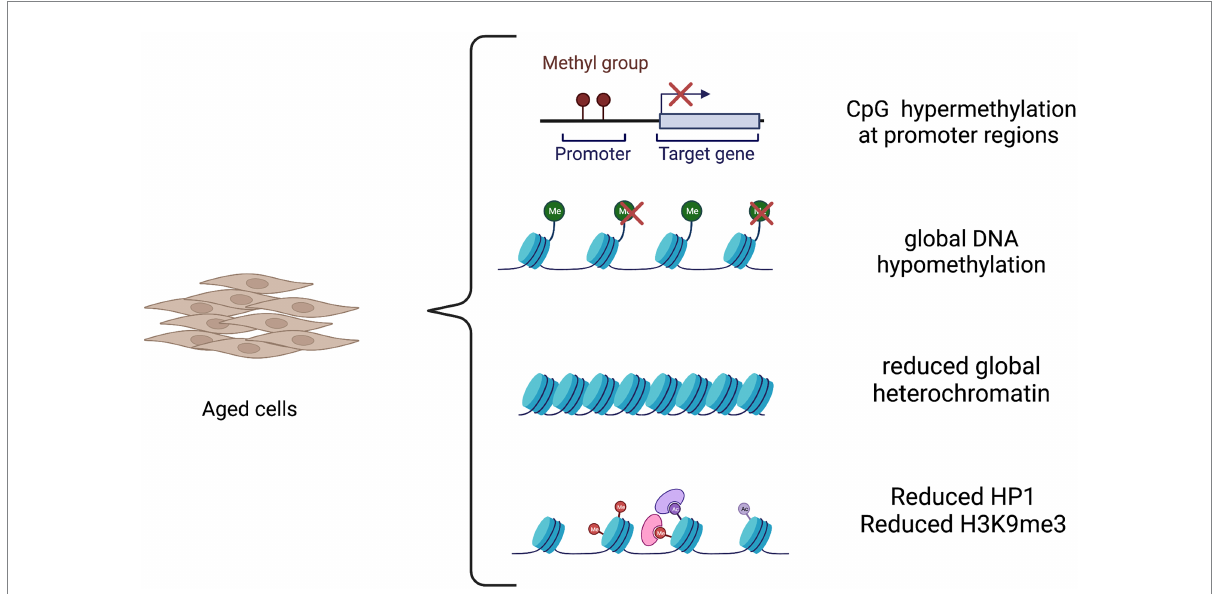
FIGURE 1 The epigenetic landscape in aging. Aging causes both global and locus-specific changes to chromatin structure. The aging process is characterized by global DNA hypomethylation except in CpG islands that become hypermethylated at promoter regions of tissue-specific genes. Moreover, there is a decrease in global heterochromatin along with a reduction in heterochromatin protein 1 (HP1) and in repressive histone mark